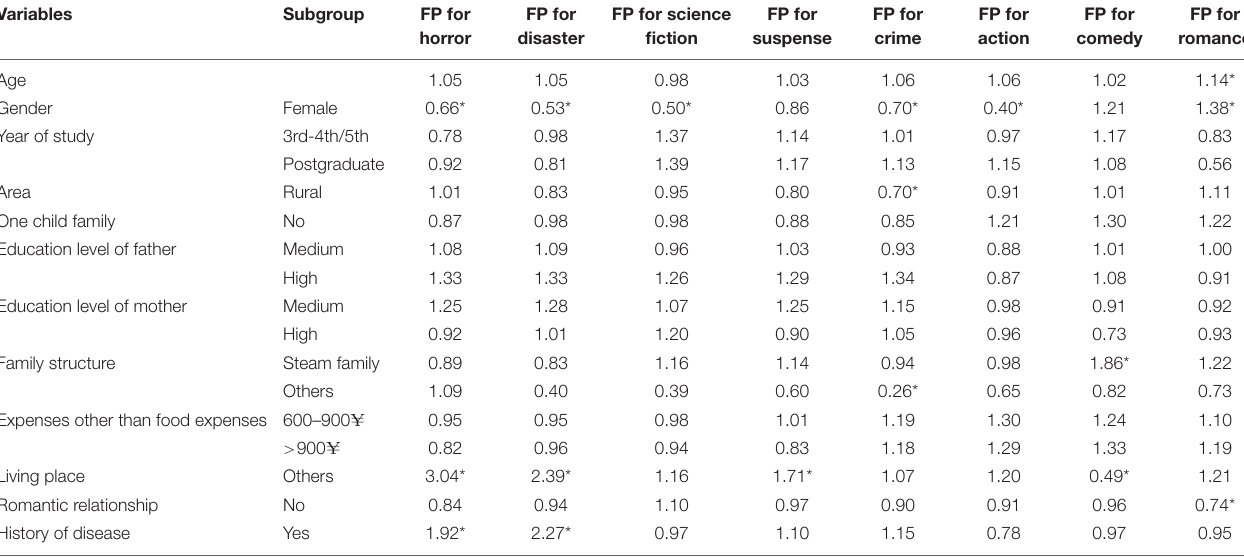
TABLE 2 | Odds ratio (OR) estimated by logistic regression on associations between eight film genres preferences and sociodemographic factors. Variables Subgroup FP for